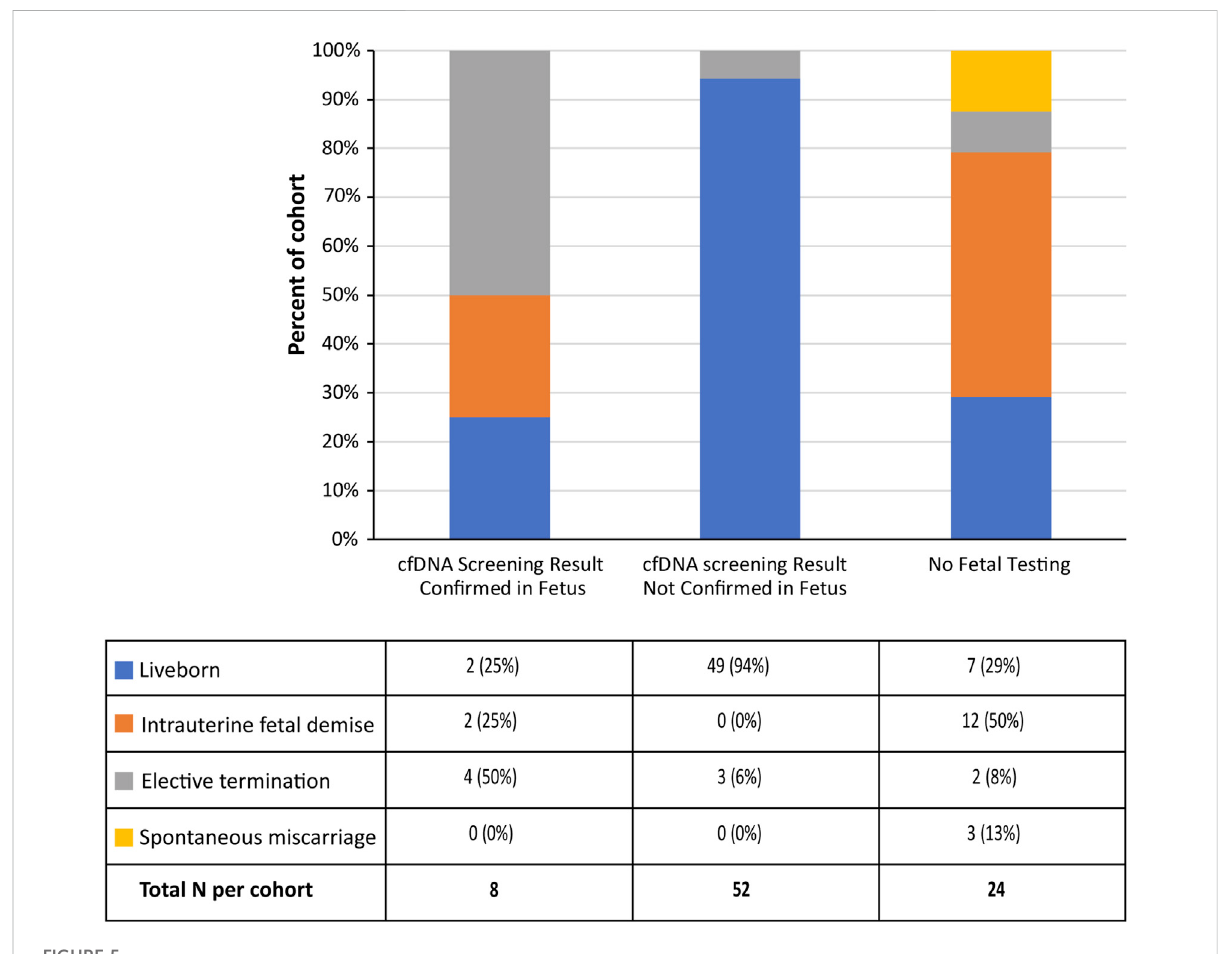
FIGURE 5 Pregnancy outcomes for the study cohort ( n =